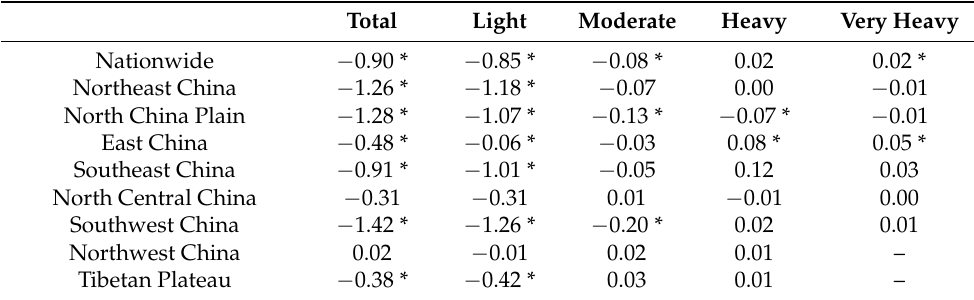
Table 2. Linear trends (days/decade) of rain-season precipitation days for different grades in China and its eight climatic regions from 1960 to 2018. Total Light Moderate Heavy Very Heavy Nationwide − 0.90 * − 0.85 * − 0.08 * 0.02 0.02 * Northeast China − 1.26 * − 1.18